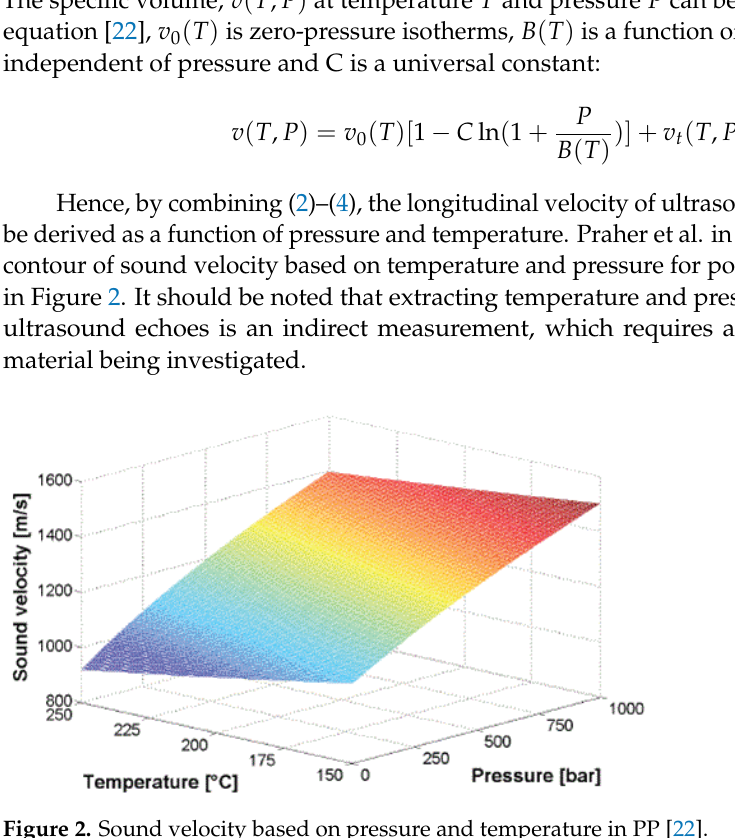
Figure 2. Sound velocity based on pressure and temperature in PP